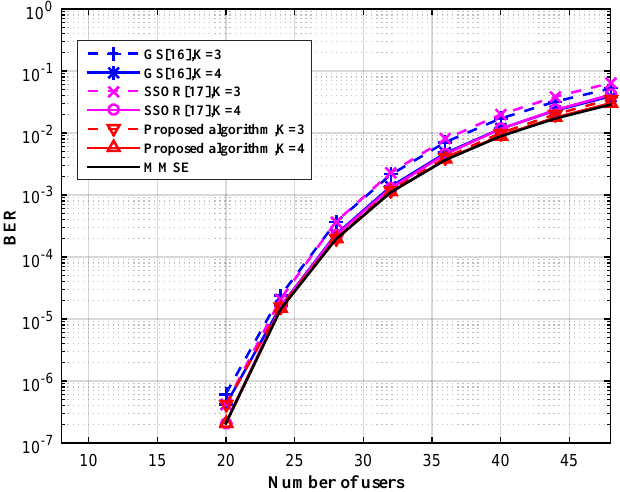
Proposed algorithm,K=3 Proposed algorithm,K=4